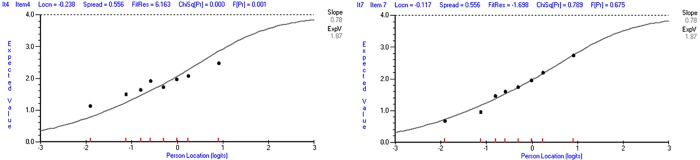
Item characteristic curve for Item 4 (left) and Item 7 (right). Note. The x-axis indicates the latent trait and the y-axis indicates the item score. The black points represent the average observed item responses in each class interval. The grey logistic curve indicates the expected item responses. The slope of the Item Characteristic Curve indicates the rate of change of the expected value with respect to the latent trait at the mid-point between the minimum and maximum scores.